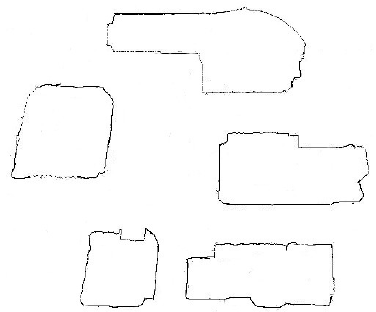
Figure 13. A portion of the Missouri University of Science and Technology campus after an edge